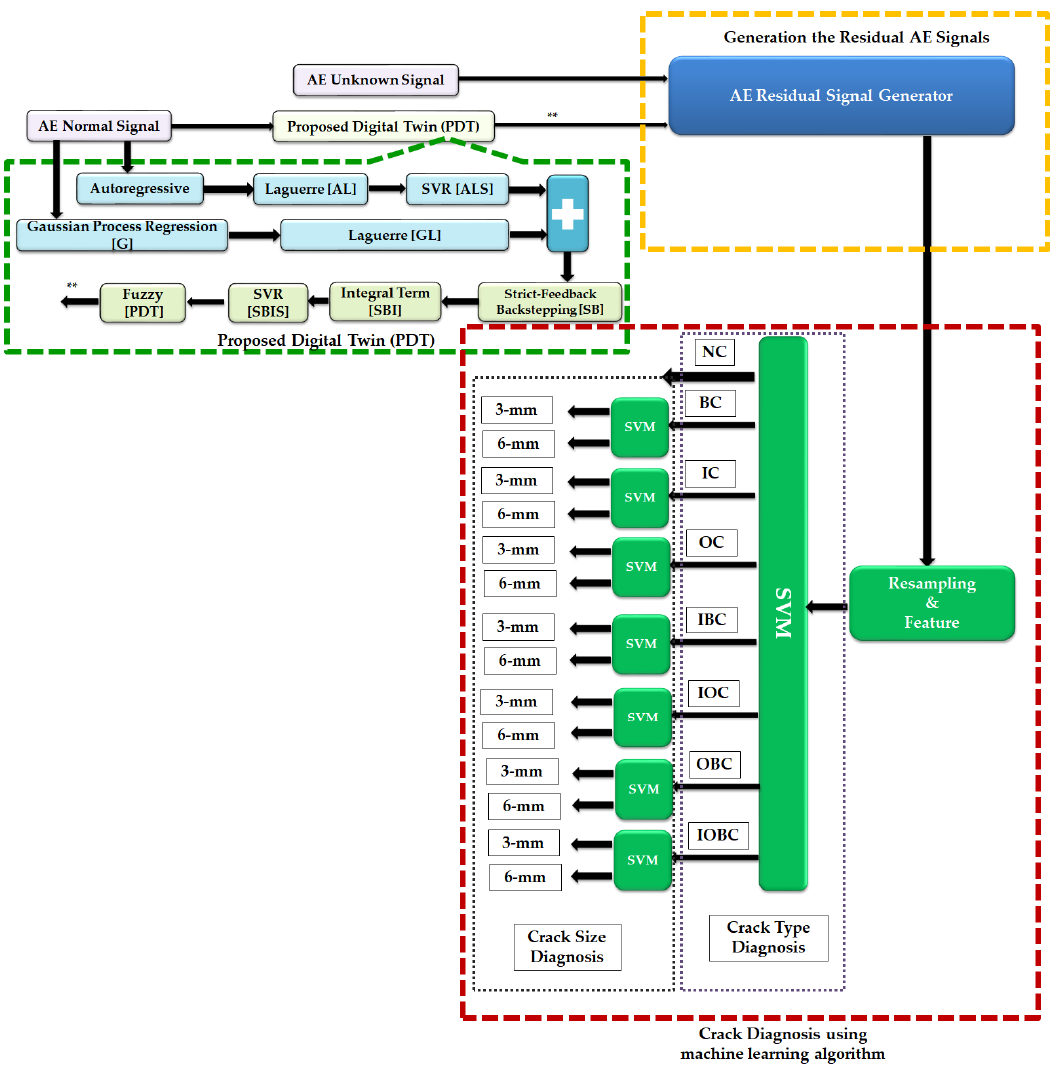
Figure 4. Structure of the proposed digital twin with machine learning for crack type/size diagnosis. **: The output of the proposed digital twin.